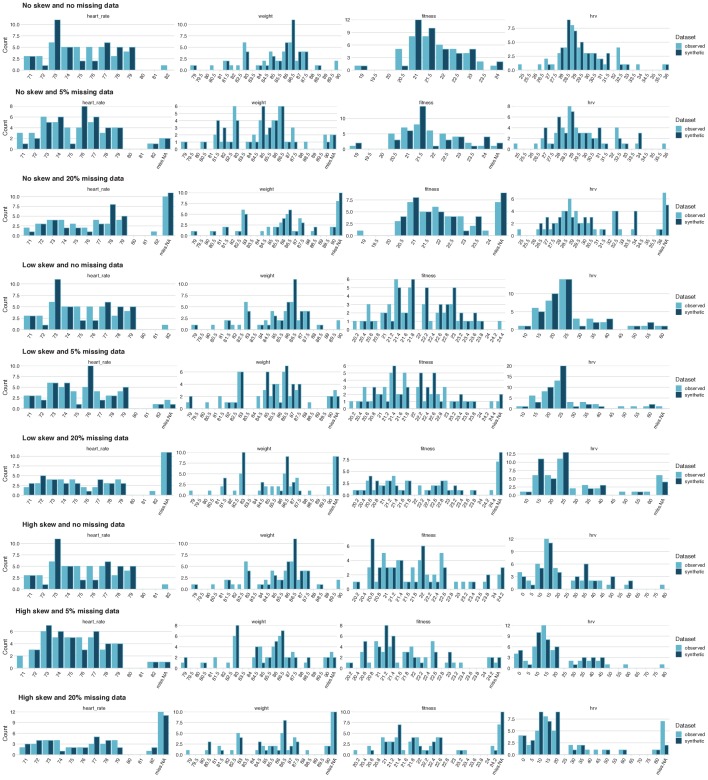
General utility of nine simulated datasets with 40 cases.Datasets varied on the shape of the distribution of heart rate variability (HRV) and the percentage of missing data.